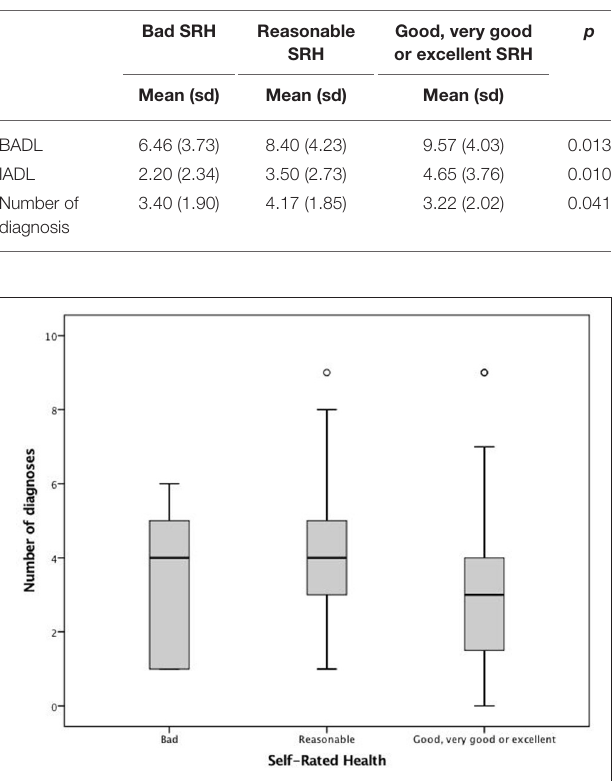
FIGURE 1 | Association between SRH and the number of diseases.